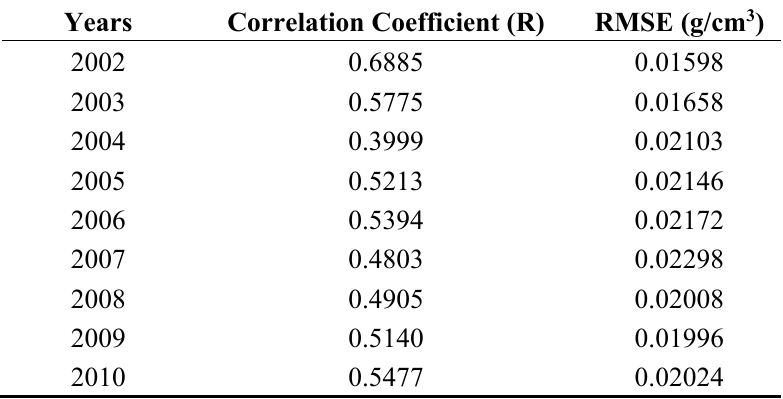
Table 5. The fitting parameters of the scatterplots in Figure